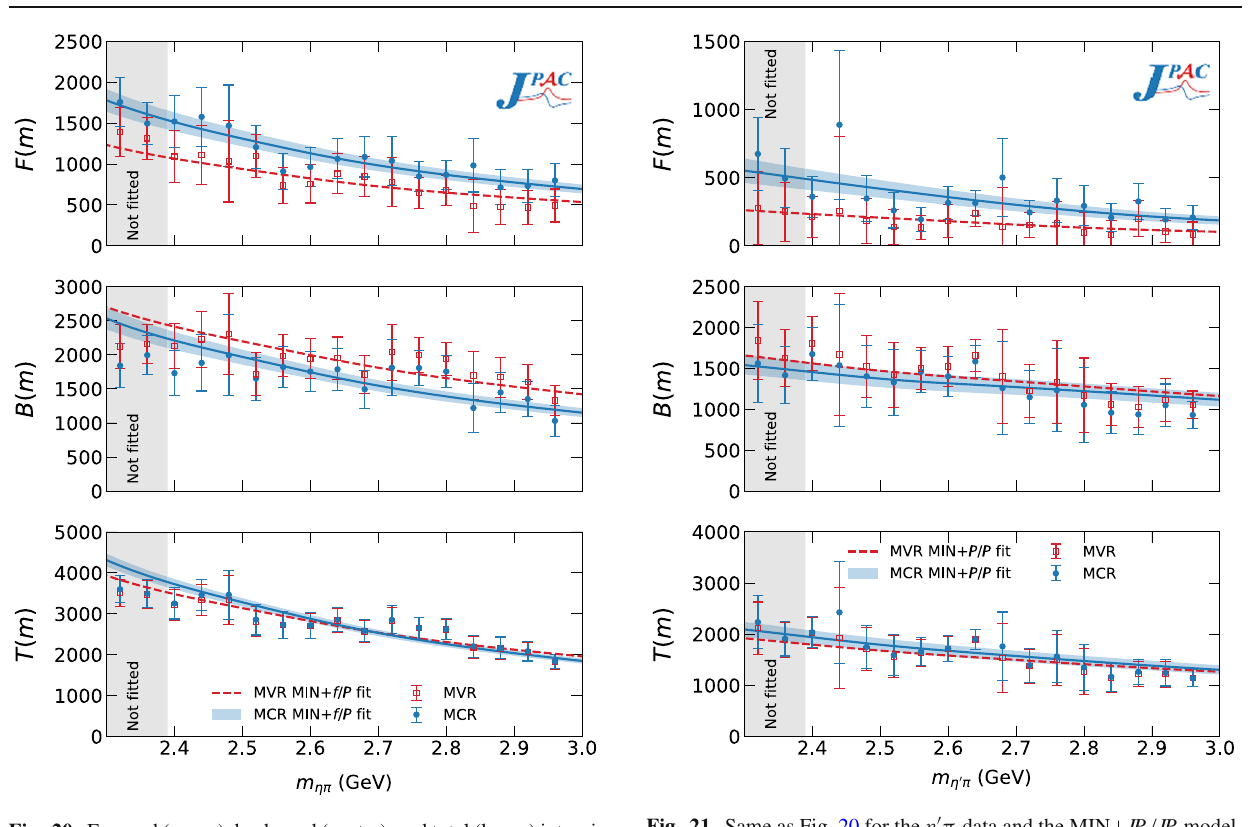
Fig. 20 Forward (upper), backward (center), and total (lower) intensi- ties for the ηπ channel as defined in Eq. (5) for the MCR and MVR and their respective MIN + f / IP fits. We show as experimental MVR error bars the same computed from the MCR